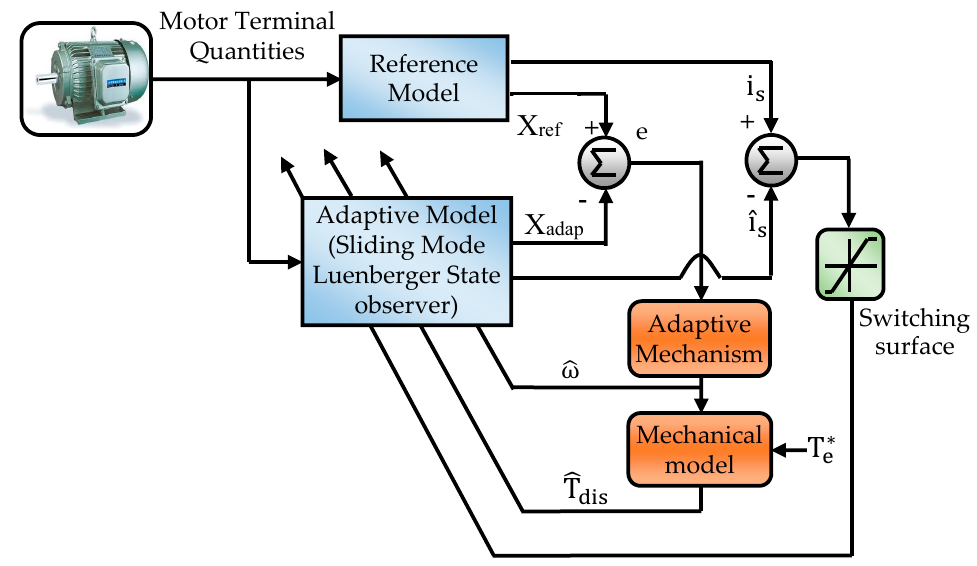
Figure 3. Basic configuration of parameter adaptive model reference adaptive system (MRAS) scheme with parallel disturbance torque estimation.